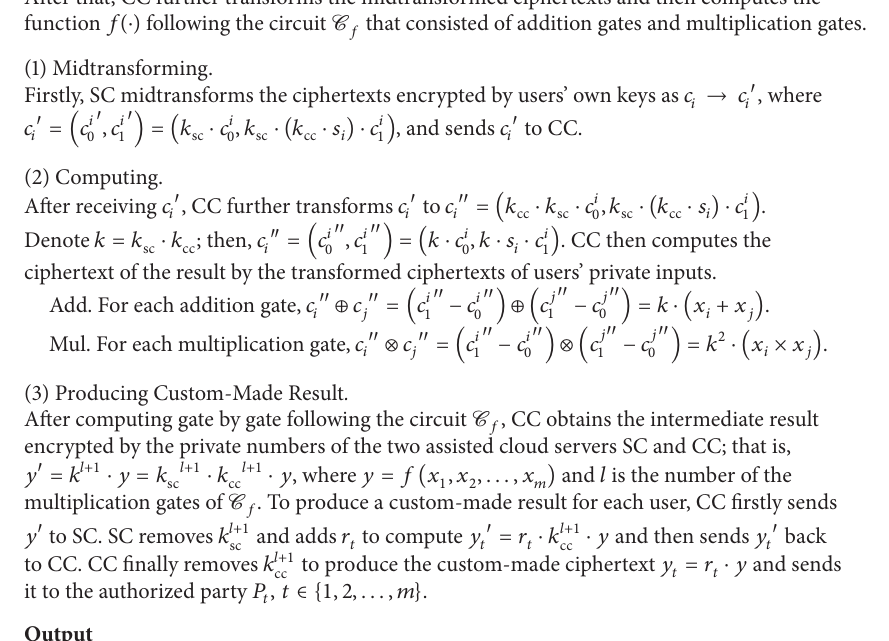
Protocol 𝜋 : Two cloud servers-assisted secure outsourcing computation